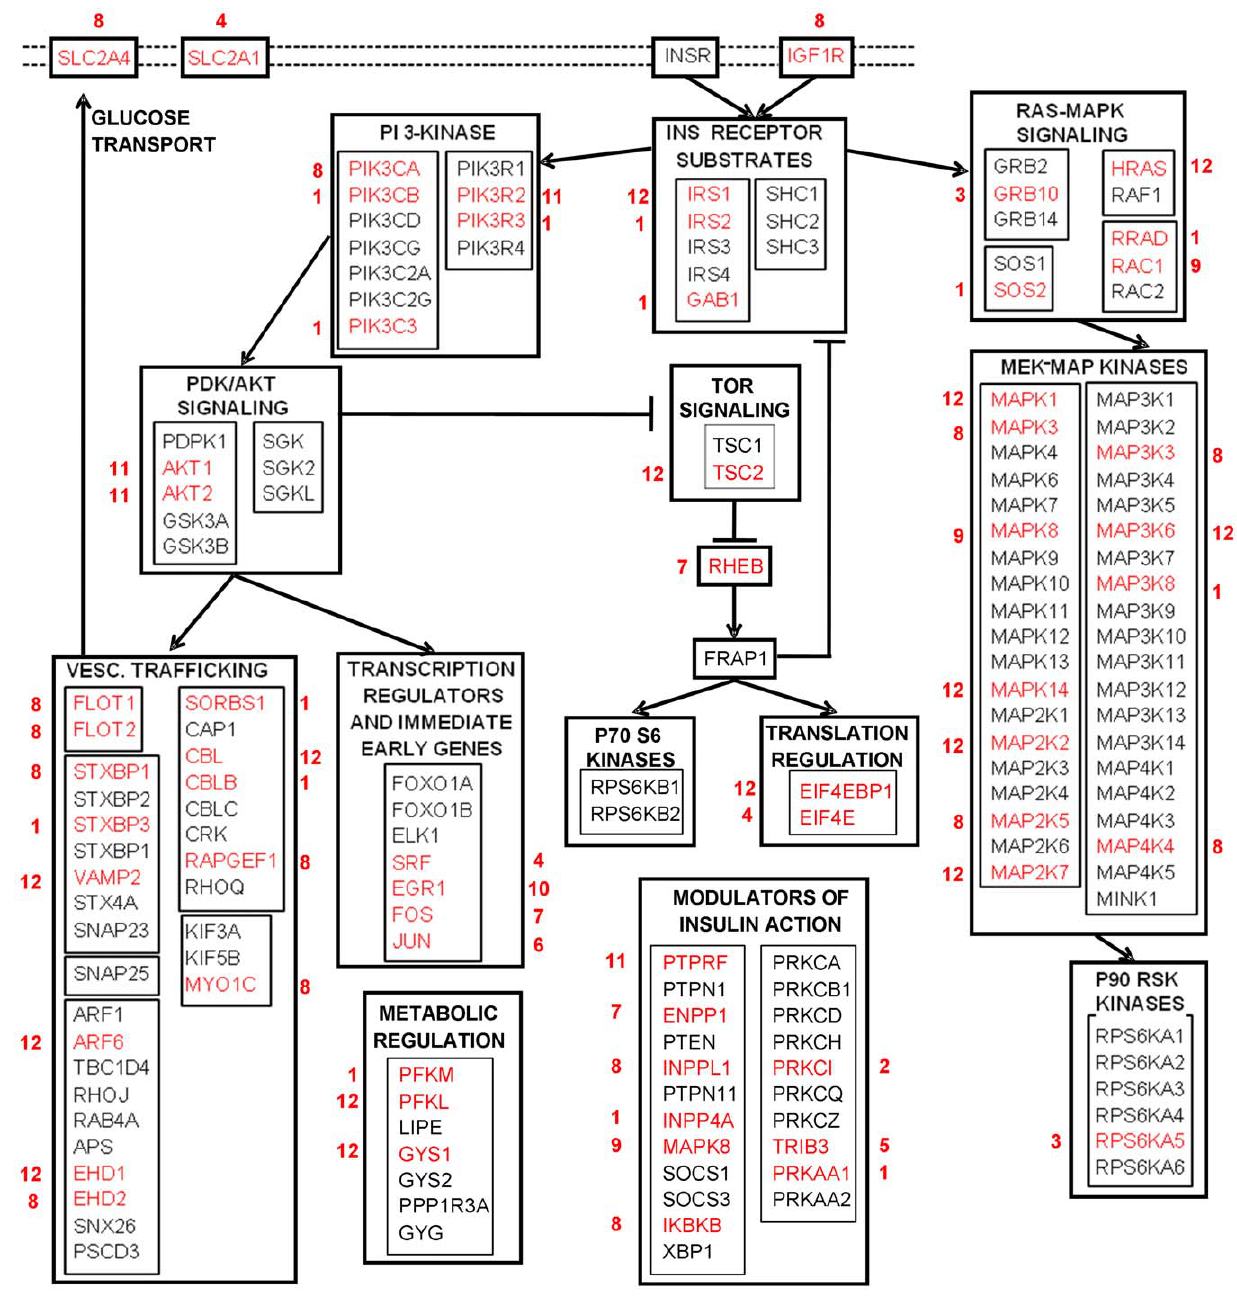
Figure 4. Mapping of differentially expressed genes on the insulin signaling pathway. 62 genes (in red) belonging to the insulin signaling pathway (GenMapp), selected as differentially expressed and associated with significant temporal expression